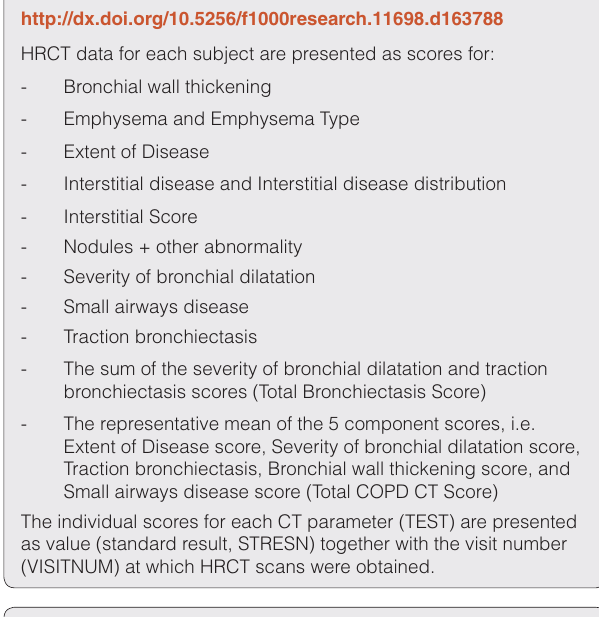
Cardiopulmonary exercise tolerance test data, i.e. heart rate, gas exchange ratio or respiratory exchange ratio (RER), absolute and